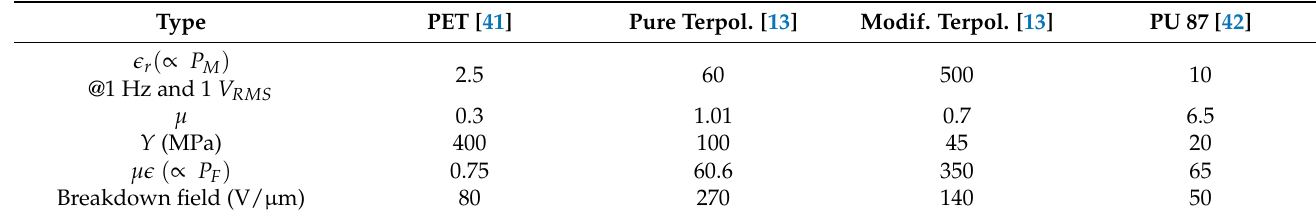
Table 1. Characteristics of different electroactive polymers.